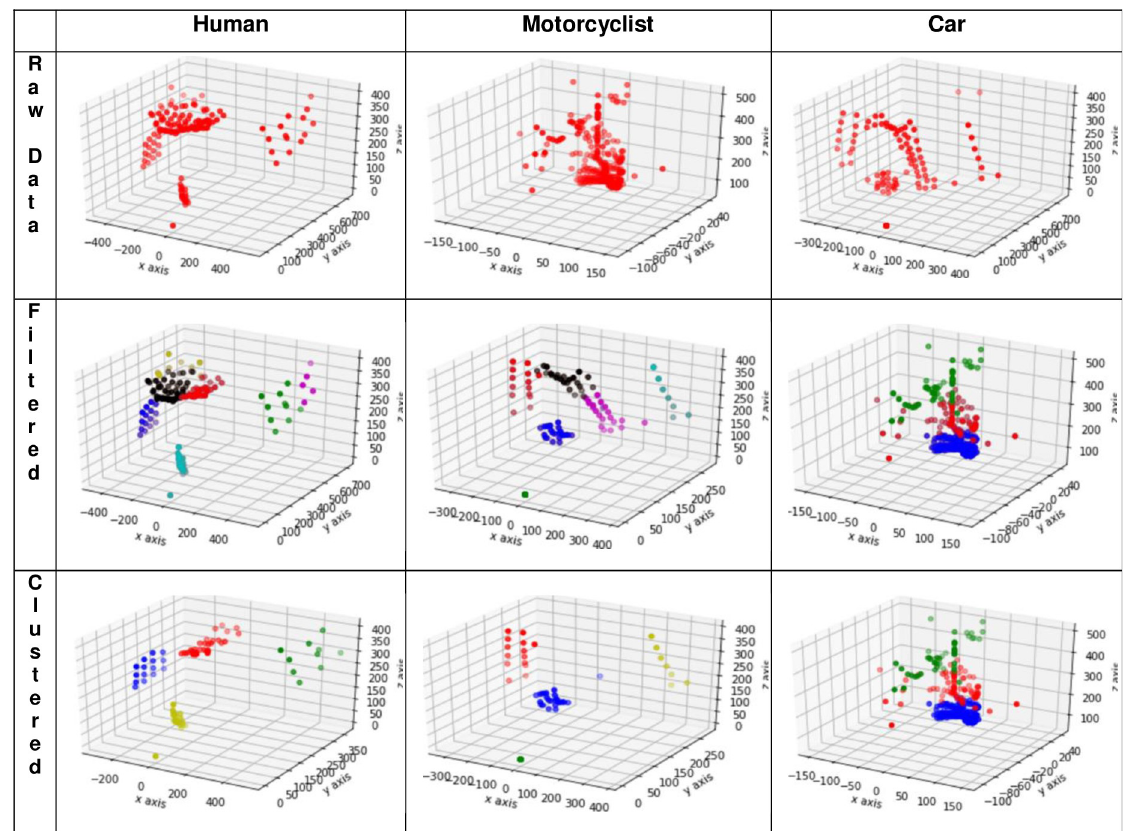
Fig 3. Point cloud data example of human, motorcyclist and car subject showing raw data, point cloud following filter process and point cloud post clustering.